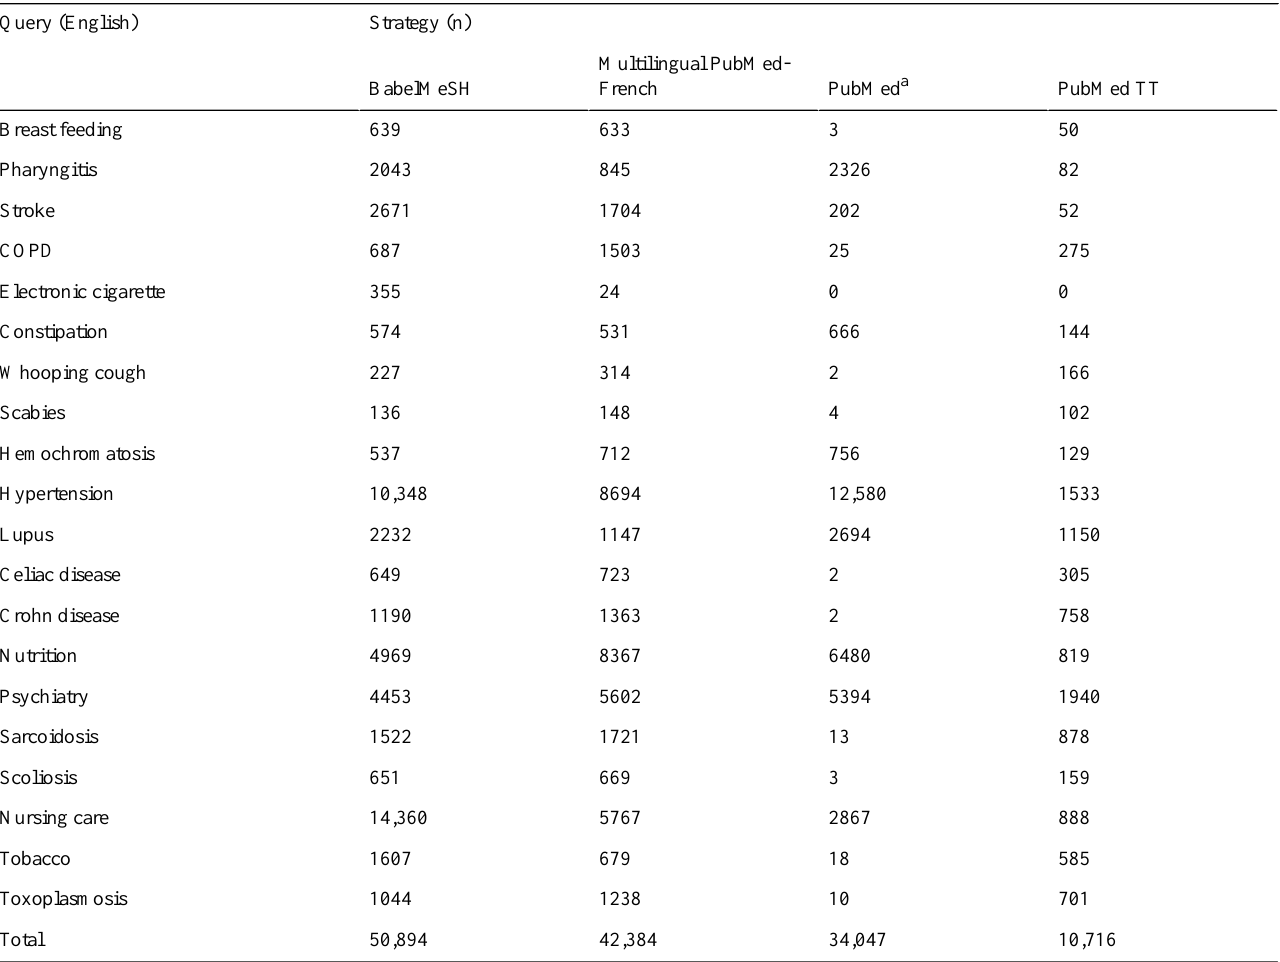
Table 4. Coverage of queries according to the search